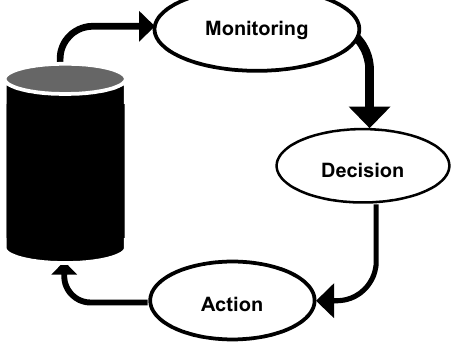
Figure 2. Closed-loop control steps of CPS.